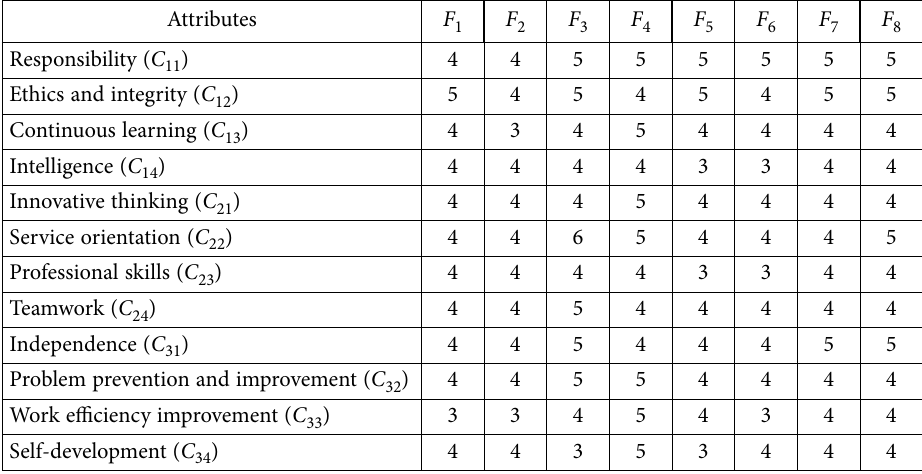
Table 9. Performance score on eight personnel Attributes F 1